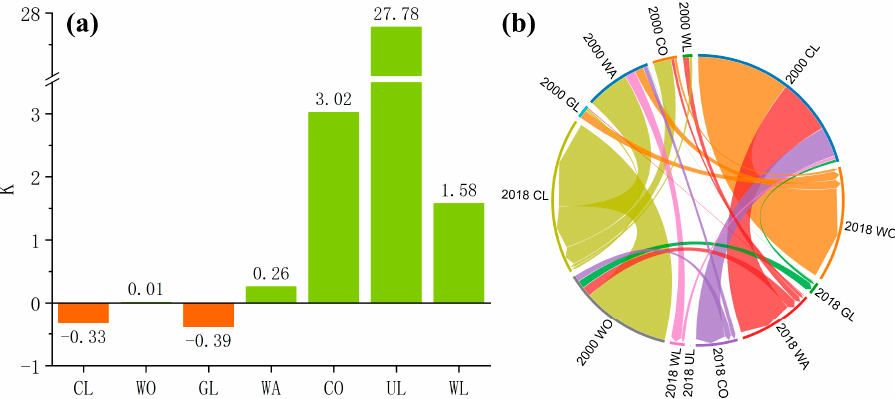
Figure 3. Dynamic degree ( a ) and mutual transformation ( b ) of land use changes in the Dongting Lake in 2000 and 2018.